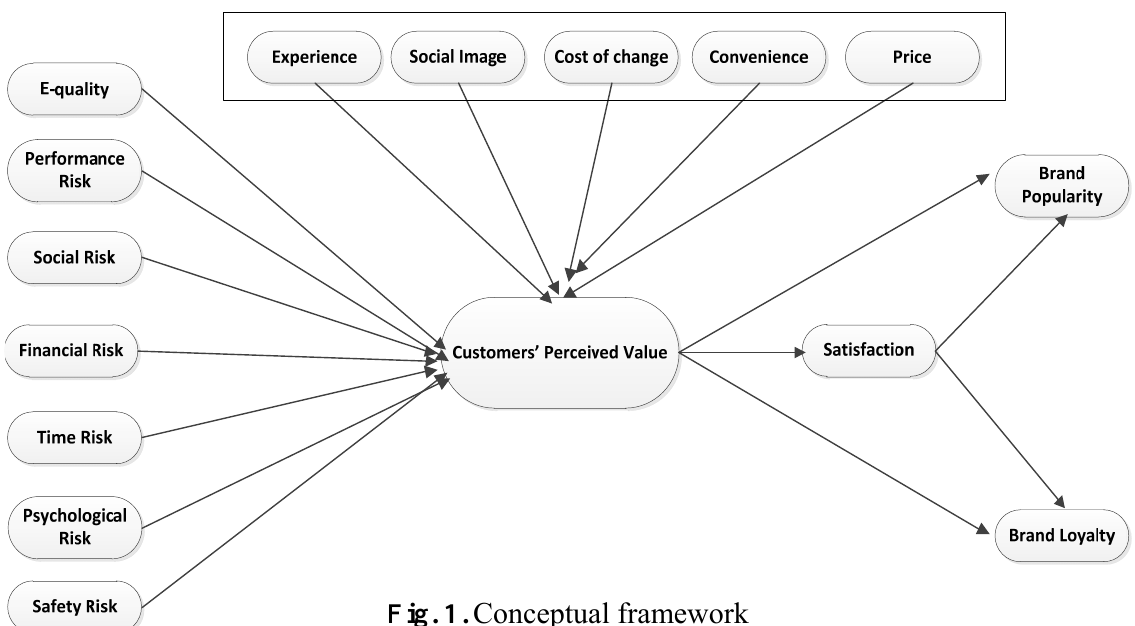
Fig. 1. Conceptual